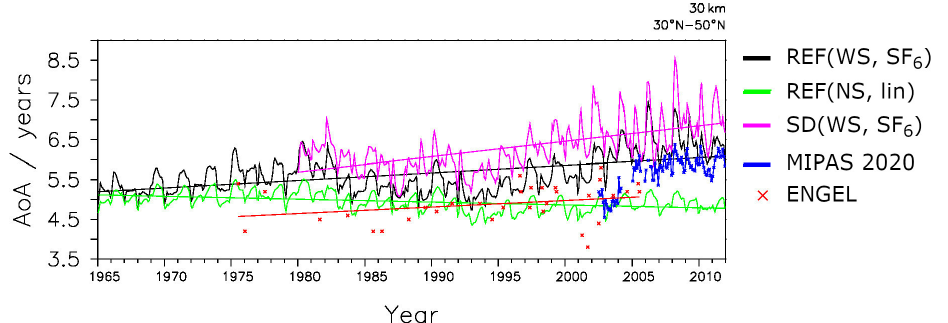
Figure 4. AoA time series and linear regressions calculated at 30km averaged over 30–50 ◦ N. EMAC AoA from SF 6 with nonlinear emissions from the reference simulations is shown in black (REF(WS, SF 6 )). AoA from the tracer with linear emissions without sinks is shown in green (REF(NS, lin)). AoA from SF 6 with nonlinear emissions with sinks in the specified dynamics simulation SD(WS, SF 6 ) is shown in pink. AoA from balloon-borne measurements (Engel et al., 2009) and AoA from MIPAS observations (Stiller, 2021) are shown in red and dark blue,